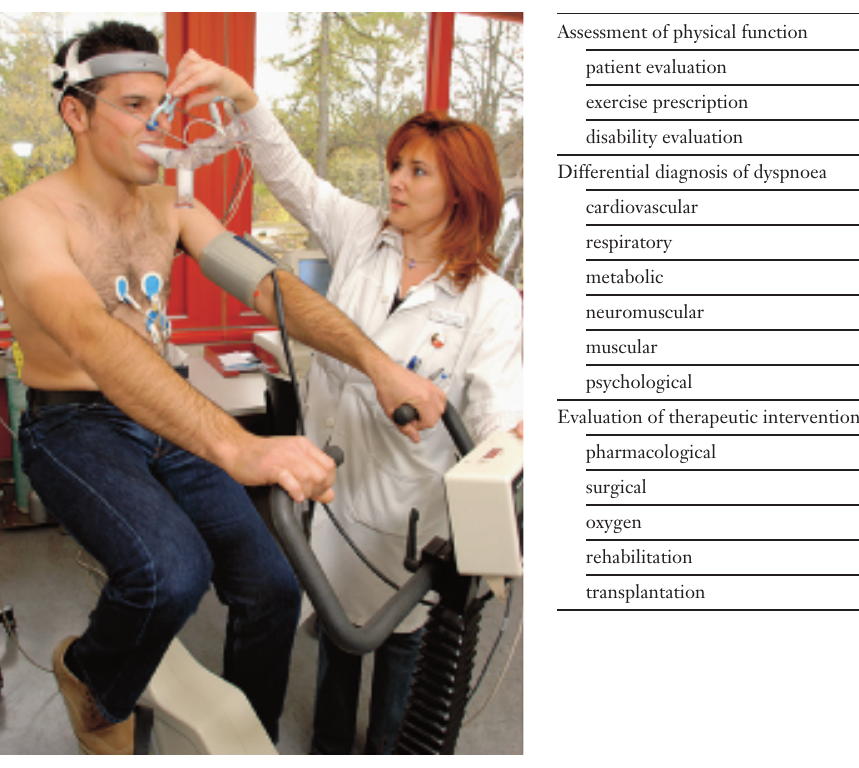
Exercise testing as a tool to better assess severity of COPD and to find disease-modifying